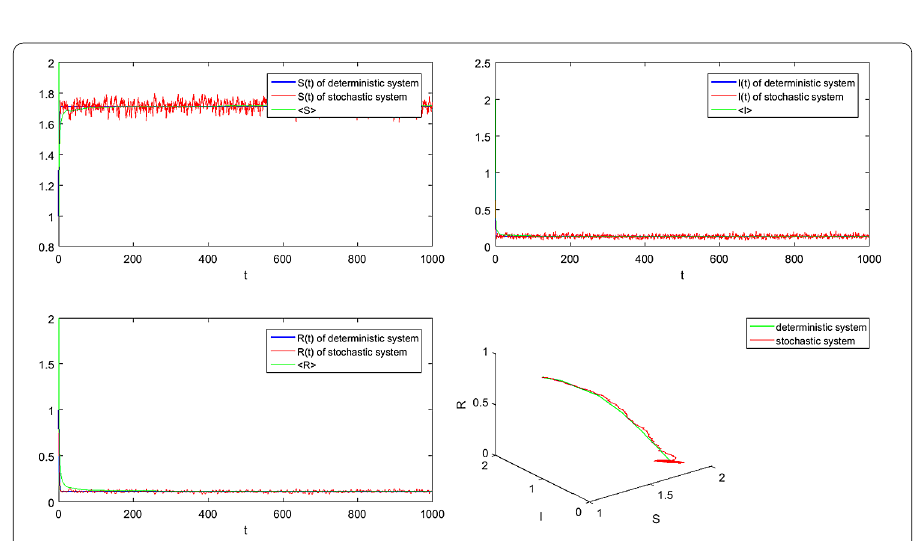
Figure 6 Comparison of the deterministic system and the stochastic system, with (cid:2) = 2, α = 0.2, β = 2, a = 1, μ = 1, r 1 = 0.9, r 2 = 0.9, δ = 0.1, σ = 0.5, where R 0 = 1.3333 > 1, (cid:16) R 0 = 1.1667 >